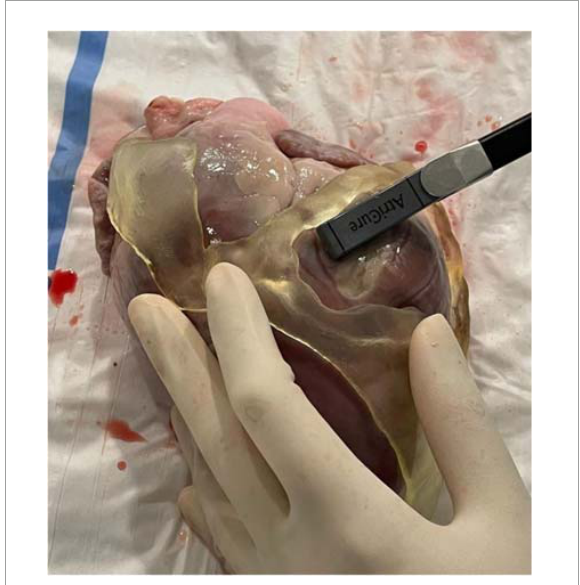
FIGURE10 Ablation catheter fitting test. Ablation catheter fitting test showed high suitability of the guide for different ablation tools, such as the bipolar radiofrequency linear catheter in the figure (bipolar unidirectional RF linear device, Coolrail, AtriC Inc., West Chester, OH, USA). All catheters could be easily positioned and manipulated within the surgical